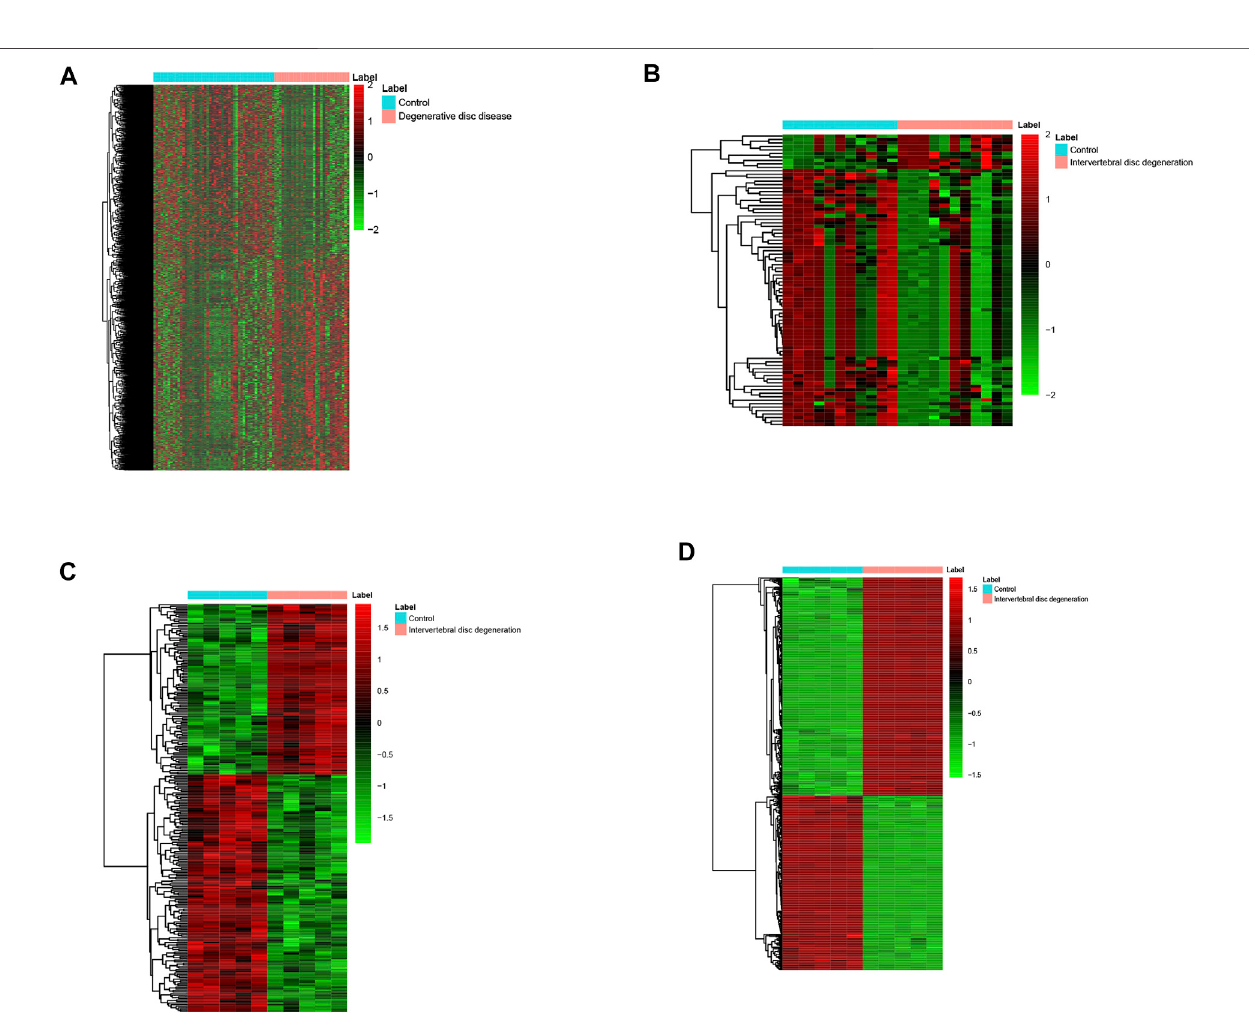
FIGURE 1 | Heatmap of DECs (A) , DELs (B) , DEMis (C) , and DEMs (D) in IDD and healthy individuals. DECs: differentially expressed circular RNAs; DEL: differentially expressed long non-coding RNAs; DEMi: differentially expressed microRNAs: DEMs: differentially expressed mRNAs; and IDD: intervertebral disc